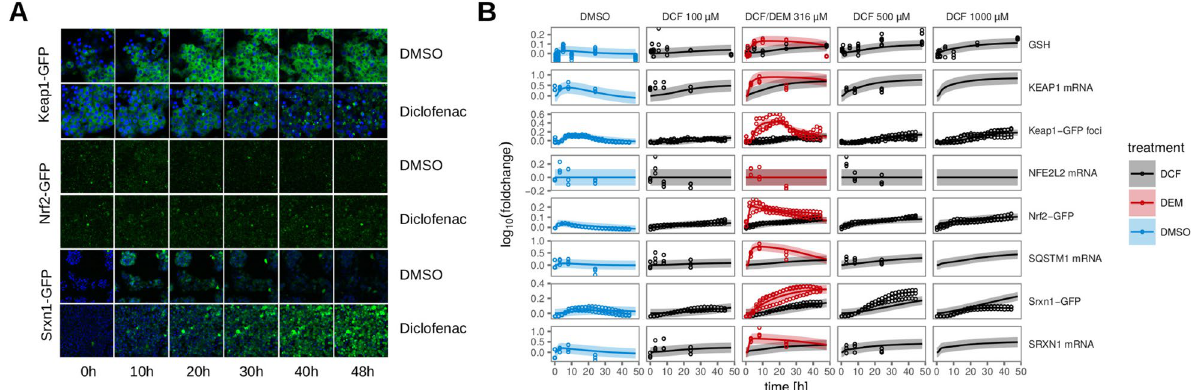
Figure 4. Response dynamics to 48 hours of treatment with DCF in Keap1-GFP, Nrf2-GFP and Srxn1-GFP cell lines. ( A ) Example images of Keap1-GFP, Nrf2-GFP and Srxn1-GFP of 0, 10, 20, 30, 40 and 48 hours timepoints for 500 µ M DCF or DMSO. The Hoechst stained nuclei are blue, the GFP signal is green. ( B ) 48 h time course upon exposure with just DMSO or with 100, 316, 500 and 1000 µ M DCF for different measurements of the Nrf2 pathway (total GSH measurements, KEAP1, SQSTM1, NFE2L2 and SRXN1 mRNA, Keap1-GFP foci, Nrf2-GFP and Srxn1-GFP). For comparison, also the DMSO control and 316 µ M DEM results are shown in red and blue, respectively. The dots represent the experimental data and the lines represent the model based estimates. Shaded areas around the model prediction indicate one standard deviation as estimated by the error